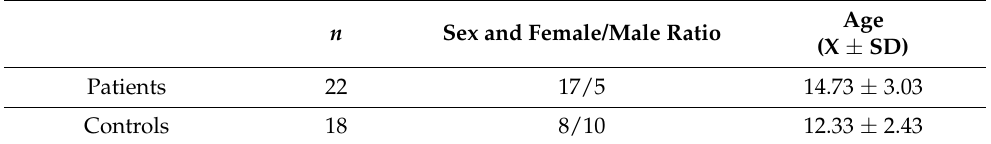
Table 1. Demographic details of the patient participant